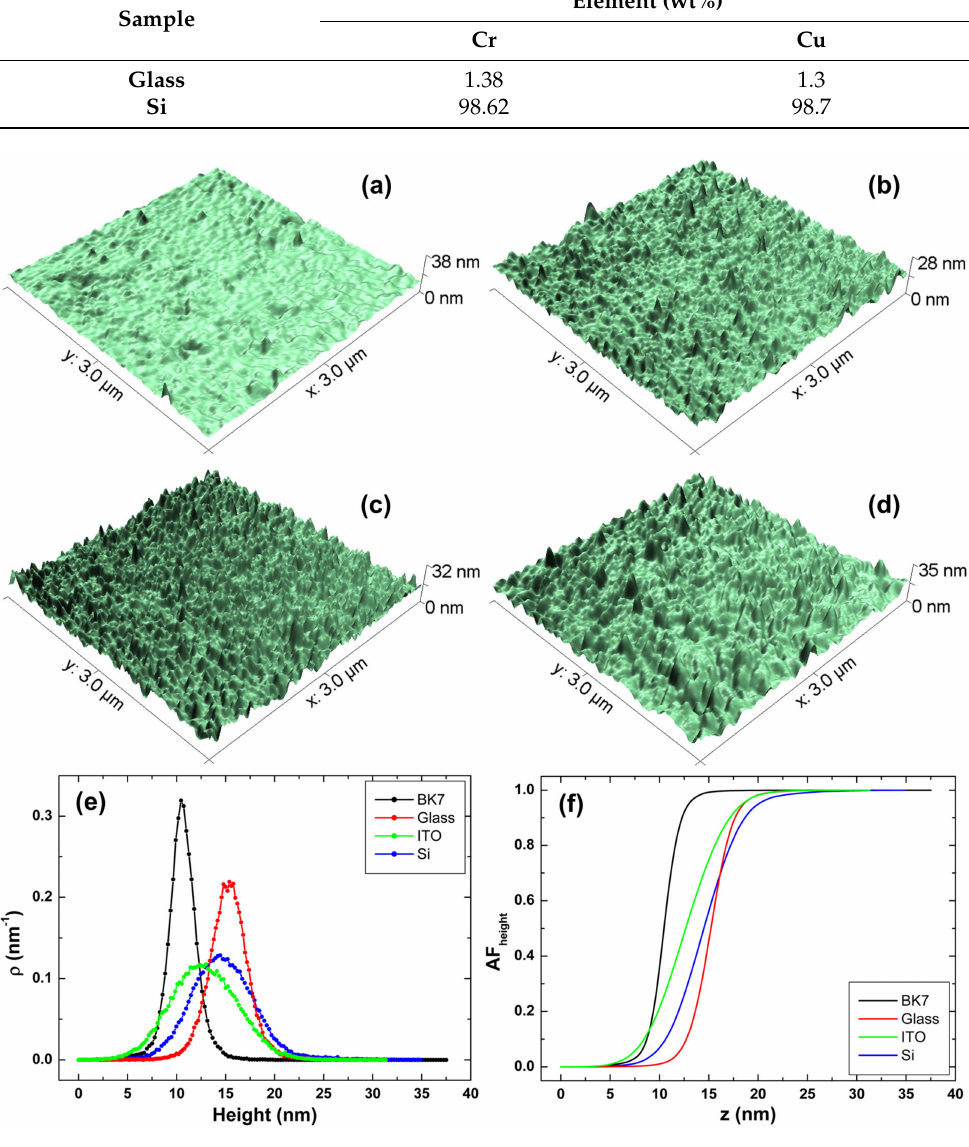
Figure 3. 3D AFM topographical maps of Cu/Cr thin films deposited on ( a ) BK7, ( b ) Glass, ( c ) ITO, and ( d ) Si substrates. Height distribution ( e ) and Abbott–Firestone curves ( f ) of Cu/Cr films deposited on BK7, glass, ITO, and Si substrates are also